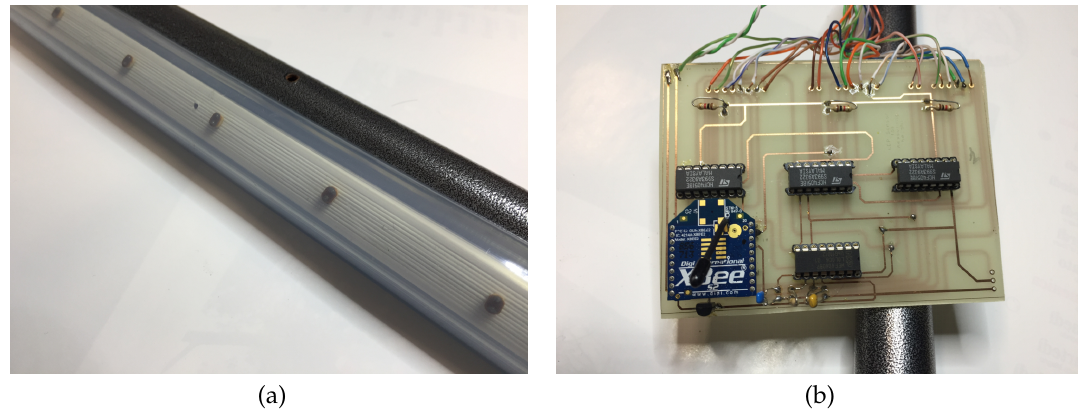
Figure 5. Sensor node components: ( a ) a portion of the pole and ( b ) the control